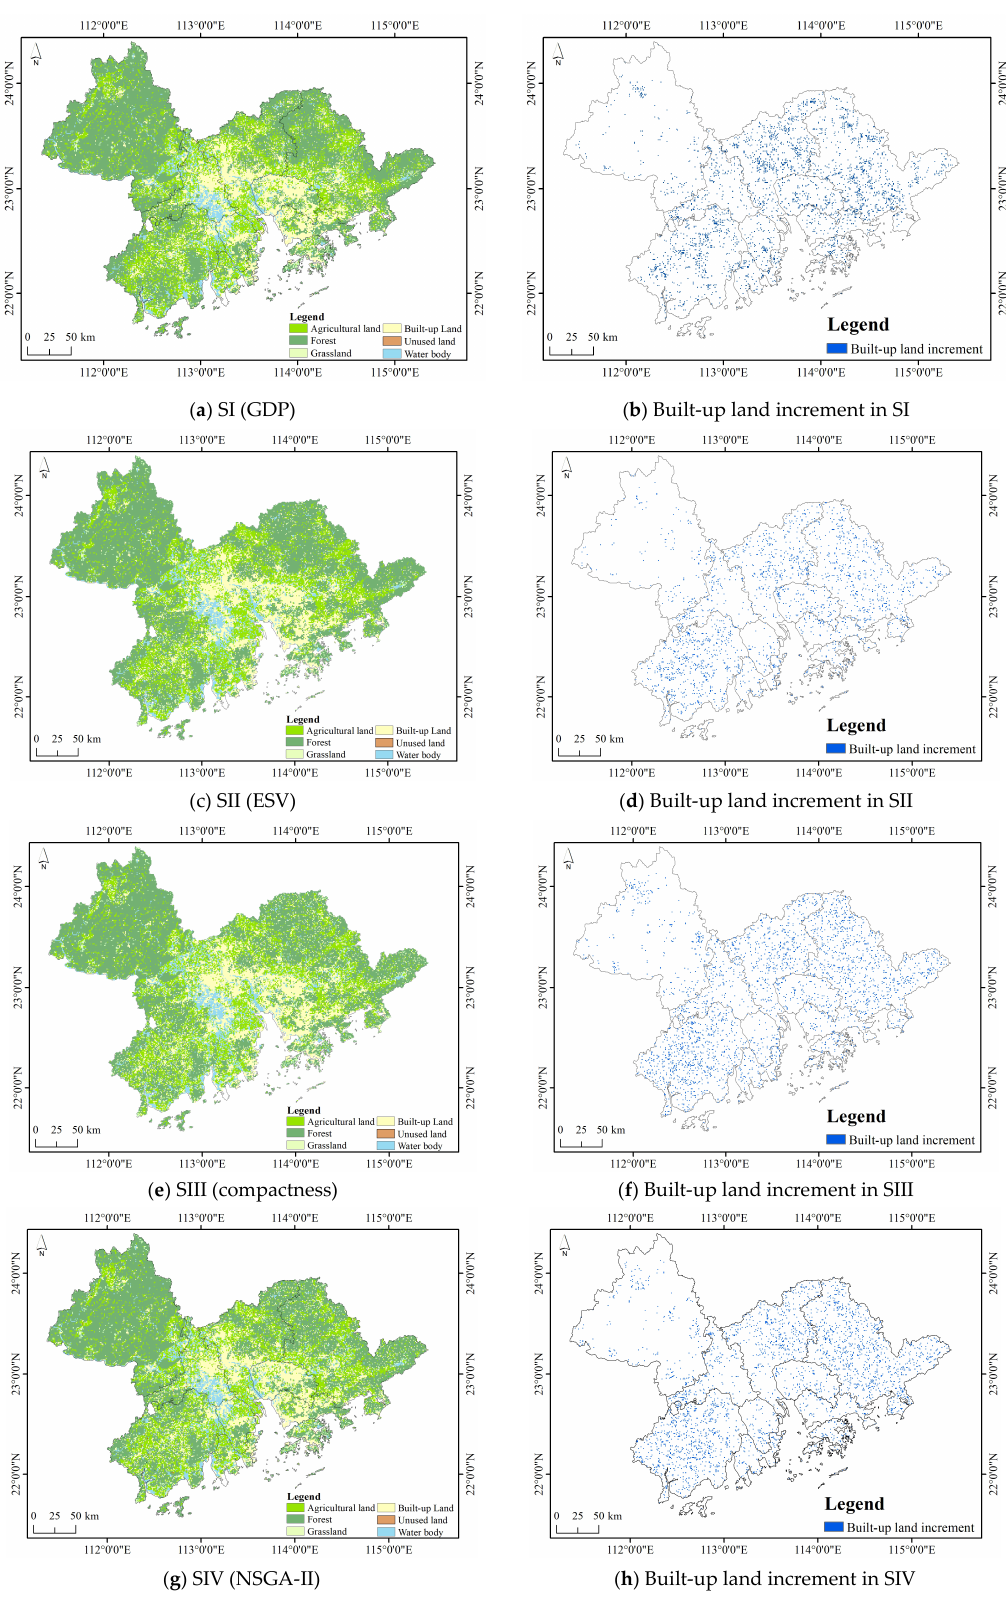
Figure 12. Distribution of land use for simulation scenarios: SI (GDP)—optimal GDP objective; SII (ESV)—optimal ESV objective; SIII (compactness)—optimal compactness objective; SIV (NSGA-II)—baseline NSGA-II algorithm, without ELI, accessibility, or NDVI. Left panels show final simulated land use patterns, while right side panels show the corresponding built-up land increment changes.